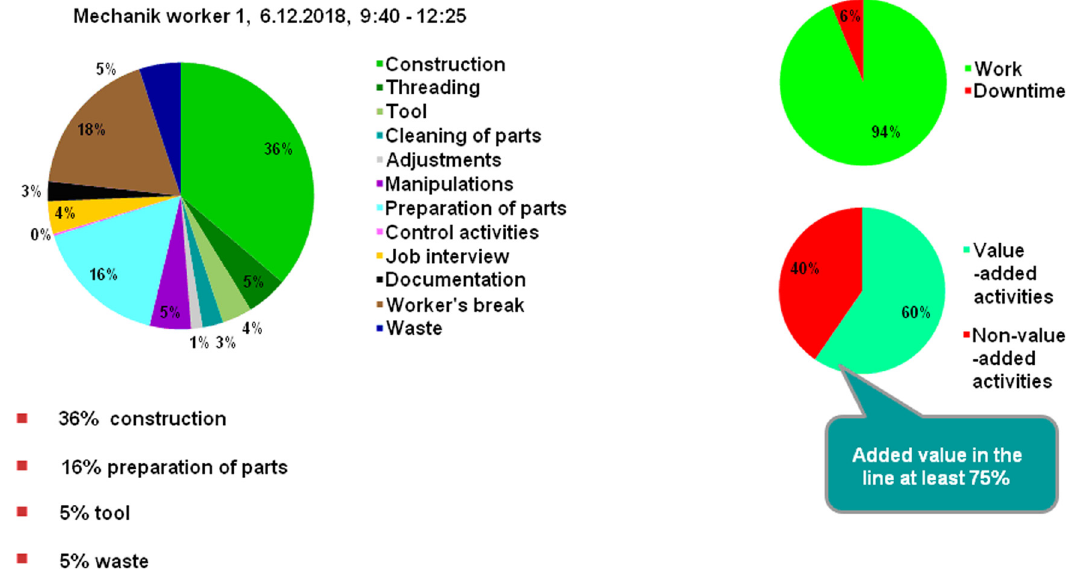
Figure 3: Snapshot example of mechanic